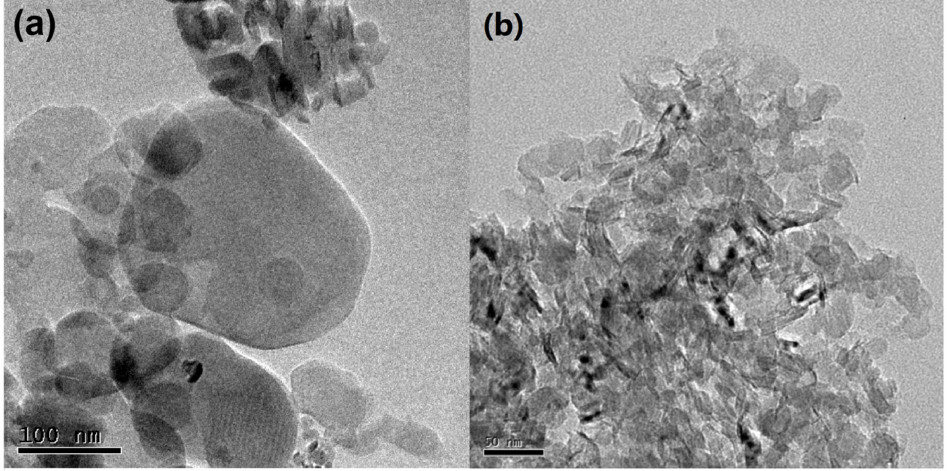
Figure 2. TEM images of ( a ) h -BN and ( b )